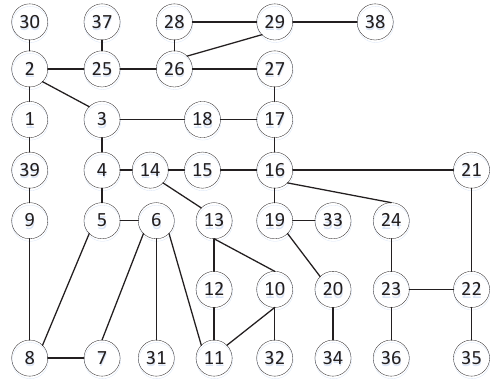
Figure 2. The IEEE 39bus as a network.